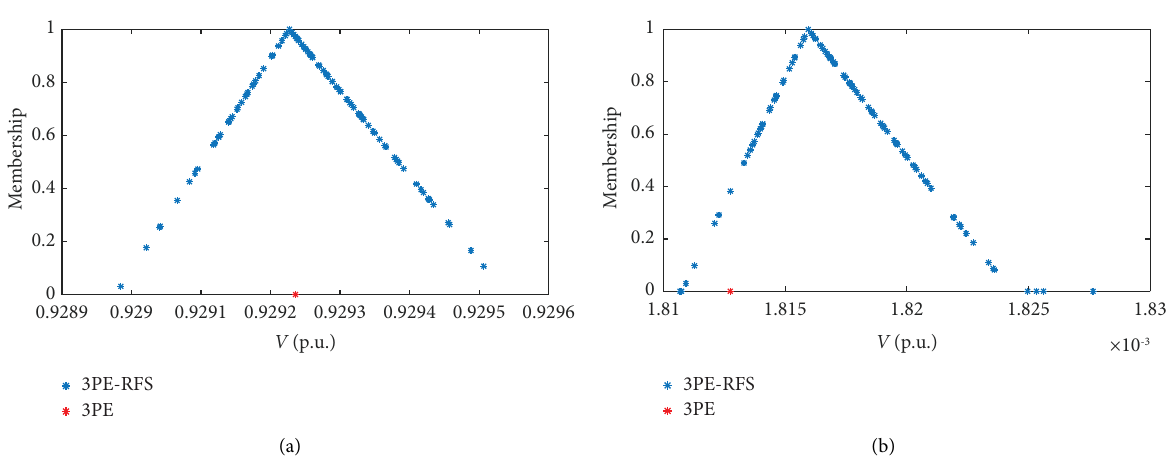
Figure 4: Membership function of V